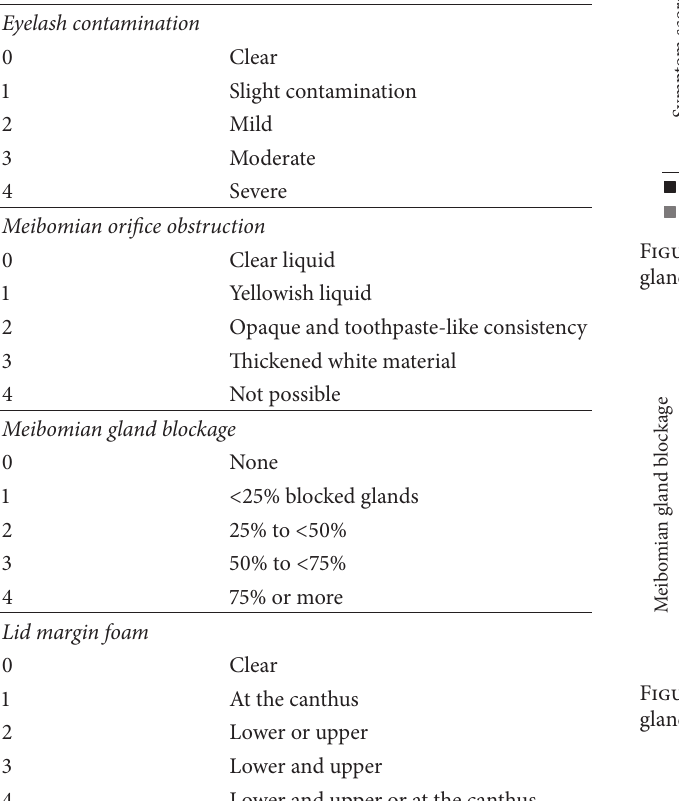
Table 5: Grading scales for signs of meibomian gland dysfunction.